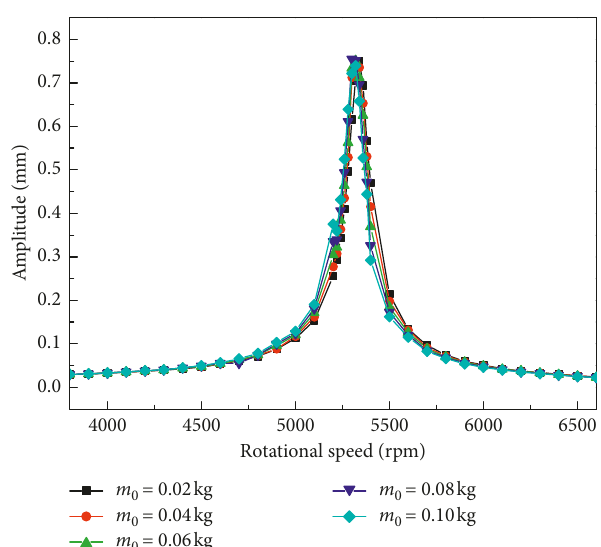
Figure 7: The influence of the mass of shrouds on the vibration